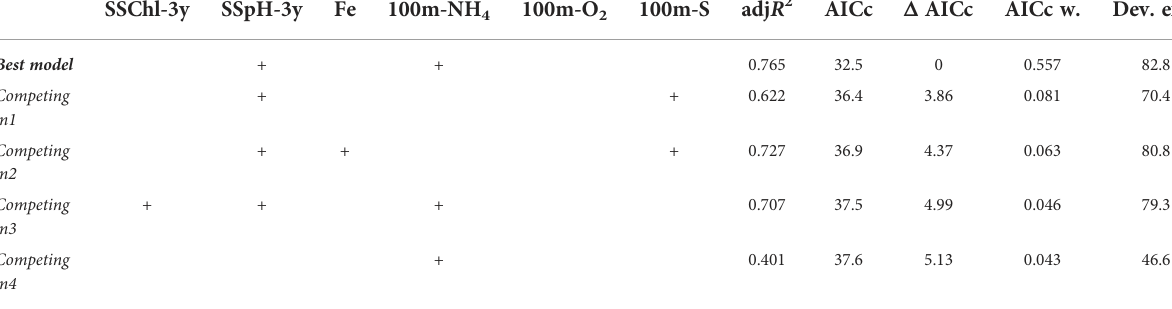
TABLE 2 Best supported and competing models for P. regalis